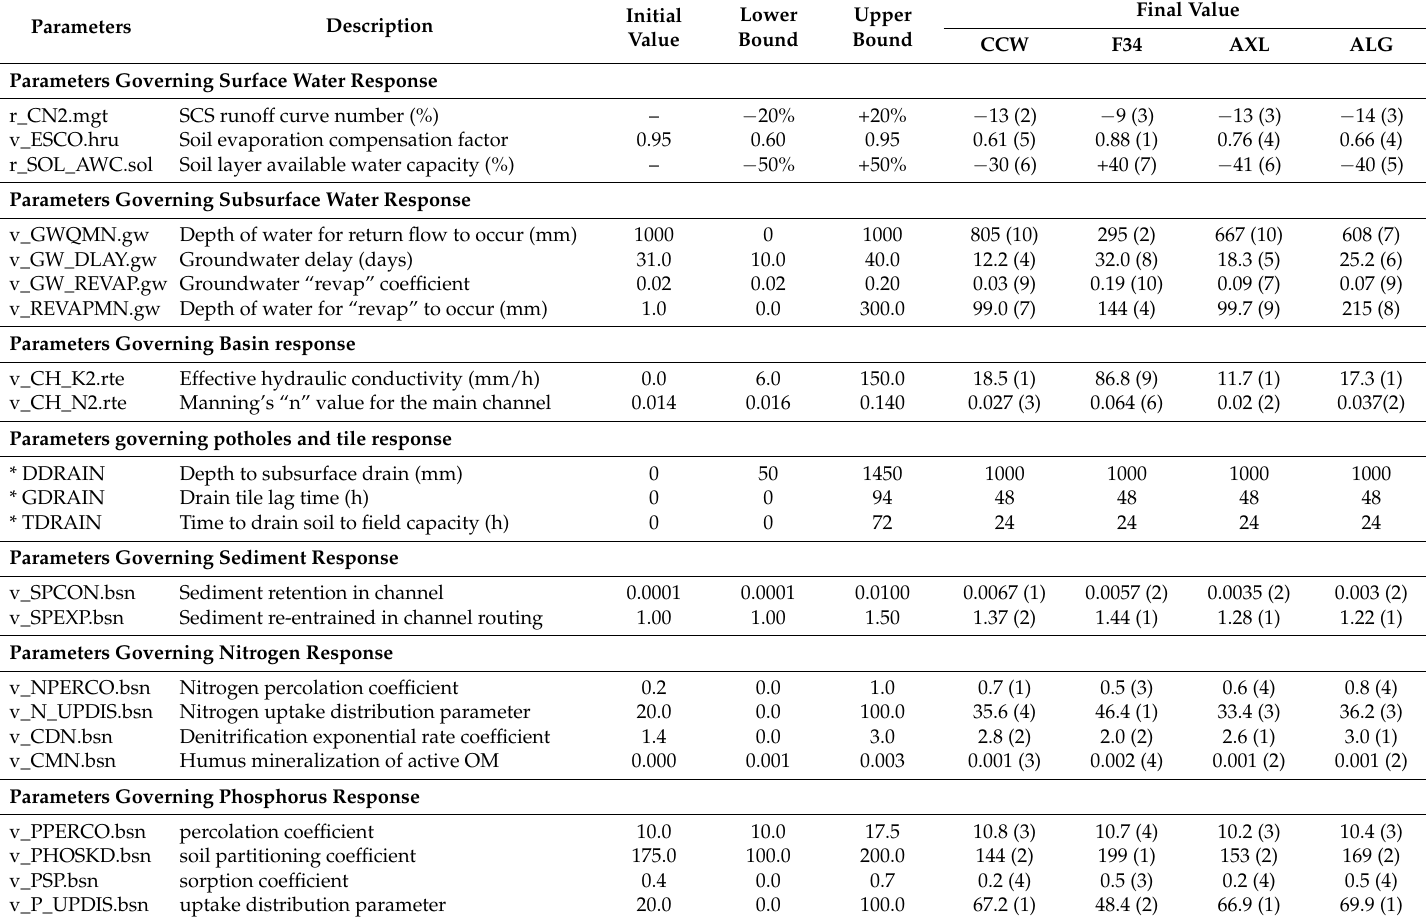
Table 7. List of SWAT parameters used for calibration of CCW, F34, AXL, and ALG